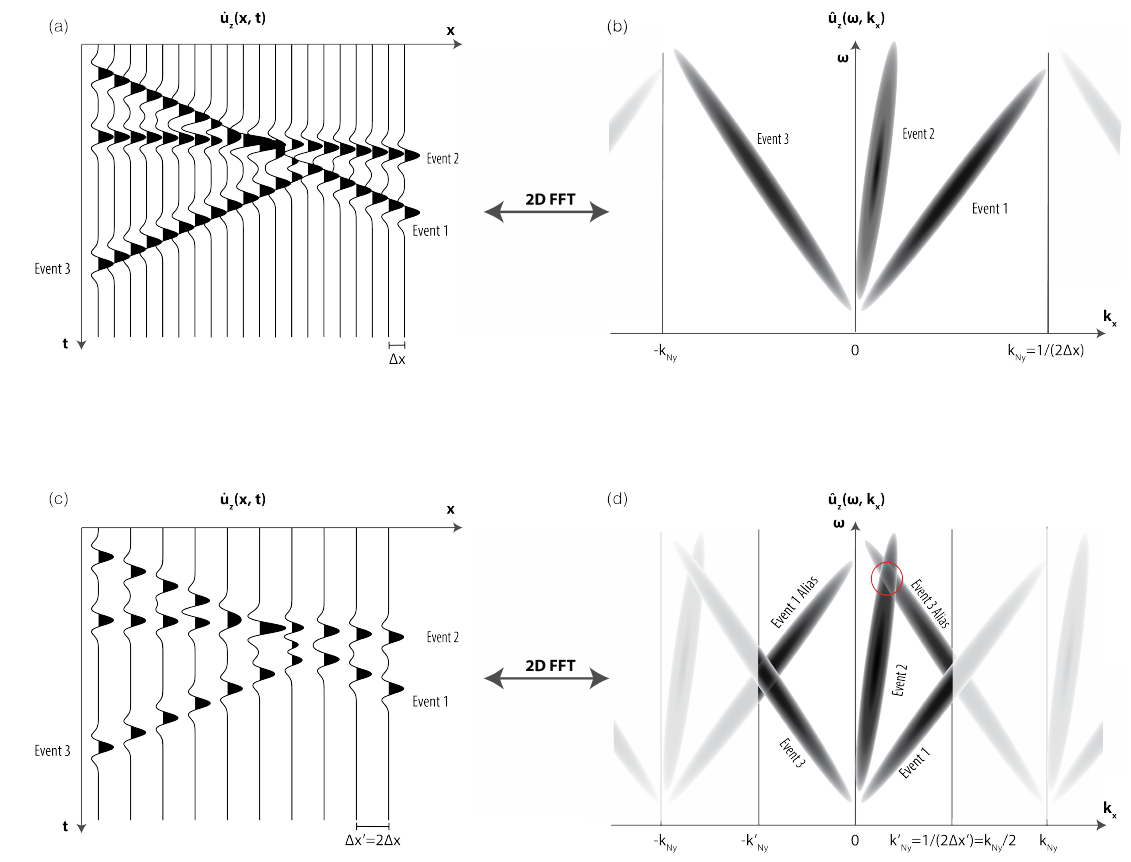
Figure 8. Spatial aliasing in the frequency-wavenumber domain ( ω - k -domain). The top two panels ( a , b ) show a wavefield that is sampled according to the Shannon-Nyquist criterion. The wavefield in the bottom two panels ( c , d ) is sampled at half the Nyquist-wavenumber leading to aliasing. The red circle marks a region where aliased and unaliased data overlap in the ω - k